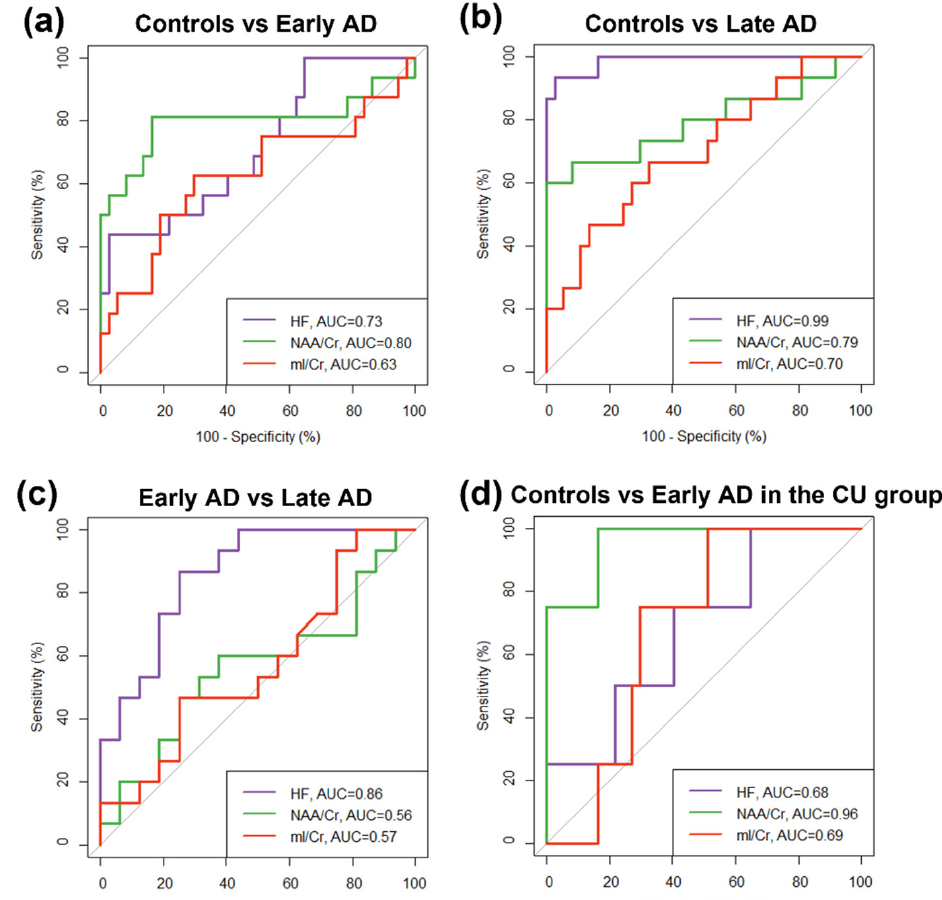
Figure 3. ROC curves of different metrics (hippocampal fraction (HF), NAA/Cr and mI/Cr) for the classification of ( a ) control vs. early AD groups, ( b ) control vs. late AD groups, ( c ) early AD vs. late AD groups, and ( d ) control vs. early AD in 41 cognitively unimpaired (CU) subjects. The area under the ROC curve (AUC) for each metric is shown. All metrics allowed a differentiation between the control and late AD groups. Only HF allowed a differentiation between the early AD and late AD groups, whereas only NAA/Cr allowed differentiation between the control and early AD groups. NAA/Cr also allowed the detection of early AD in the CU group. Table 3. Performance of metabolite ratios in classification among groups.